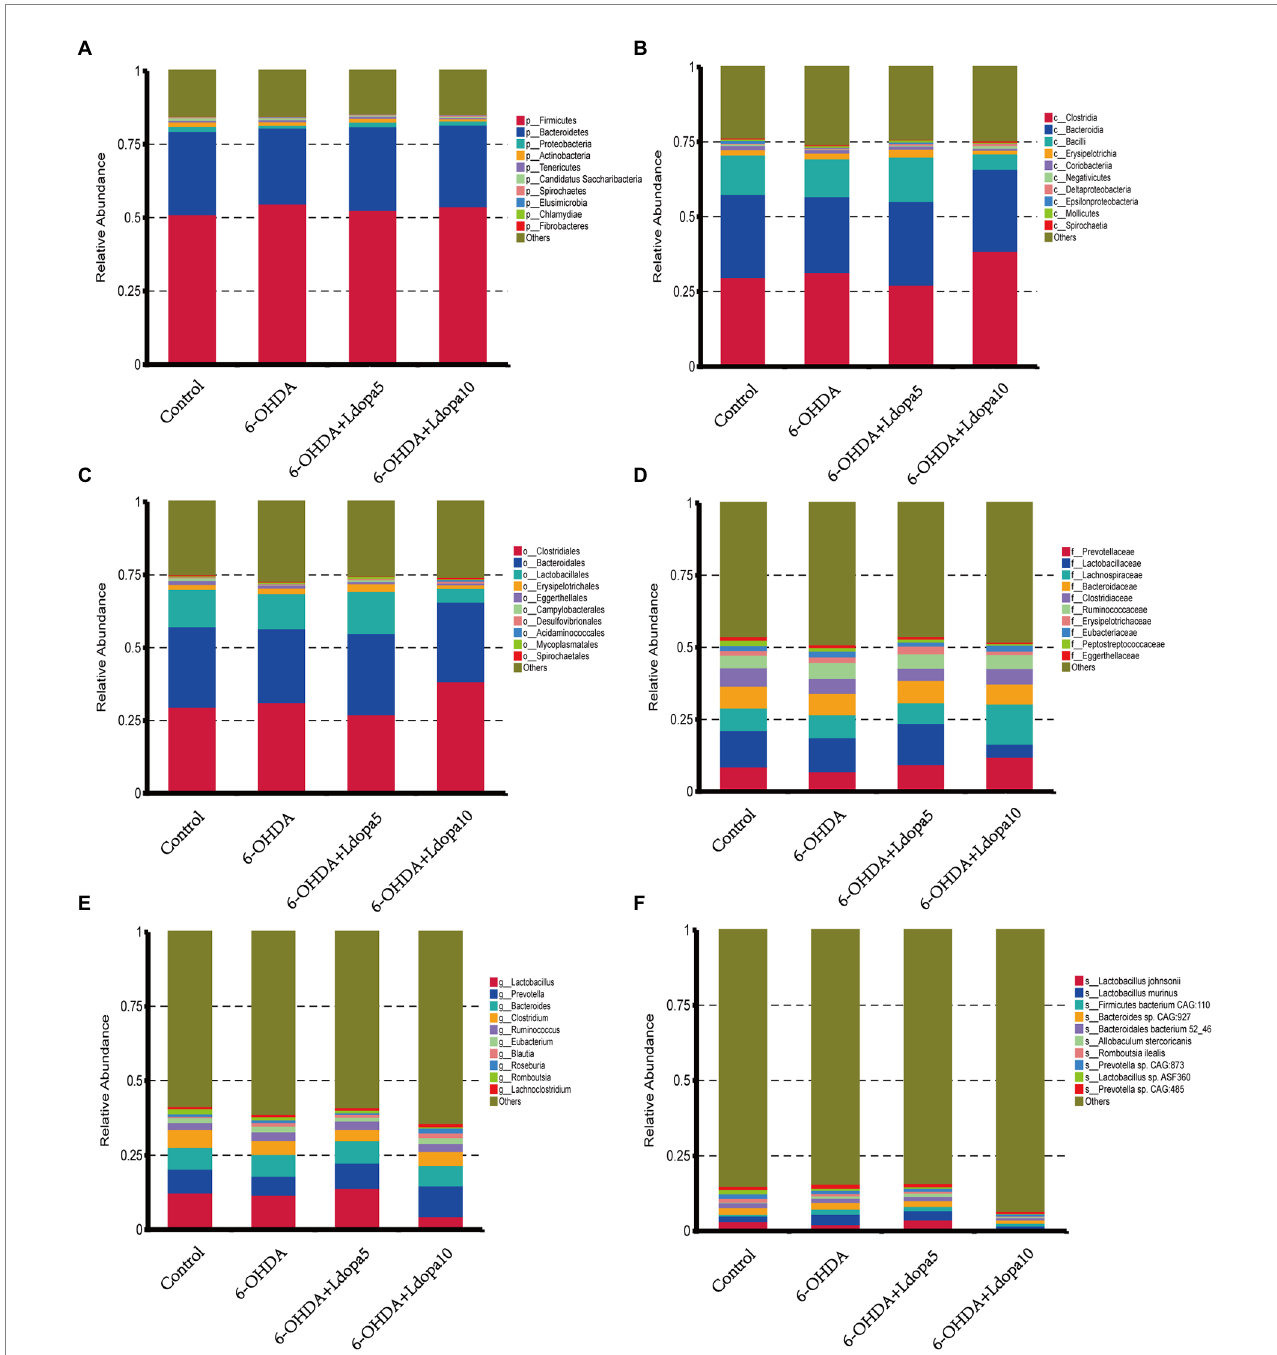
FIGURE 1 Gut bacteria composition of the 10 most abundant taxa was exhibited. Histogram of relative abundance in 6-OHDA, 6-OHDA+Ldopa5, 6-OHDA+Ldopa10 and control groups at phylum (A) , class (B) , order (C) , family (D) , genus (E) and species (F) level was discerned. The horizontal axis indicates the sample name, the vertical axis shows the relative proportion of annotations to a particular type of taxa, the taxa category corresponding to each color block are shown on the right side of the bar